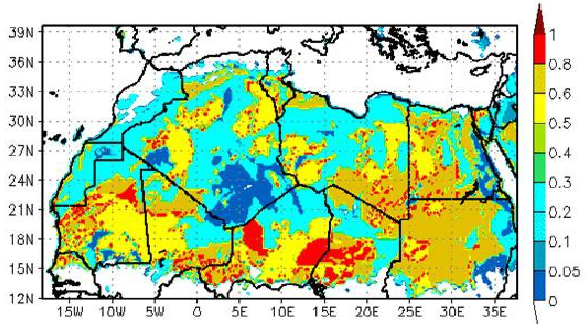
< 10 µm, c) 10 µm < D p